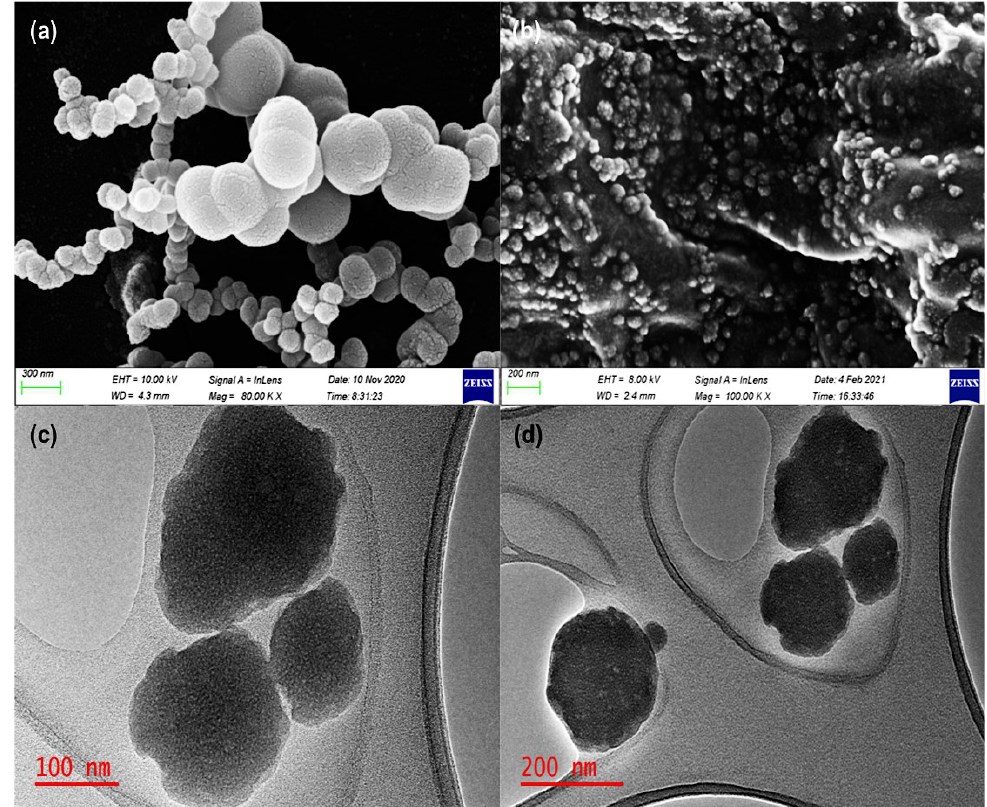
Figure 1. SEM images of NLP ( a ) and anti-calpain-NLP ( b ); TEM images of ( c ) anti-calpain-NLP at 100 nm and ( d ) at 200 nm.